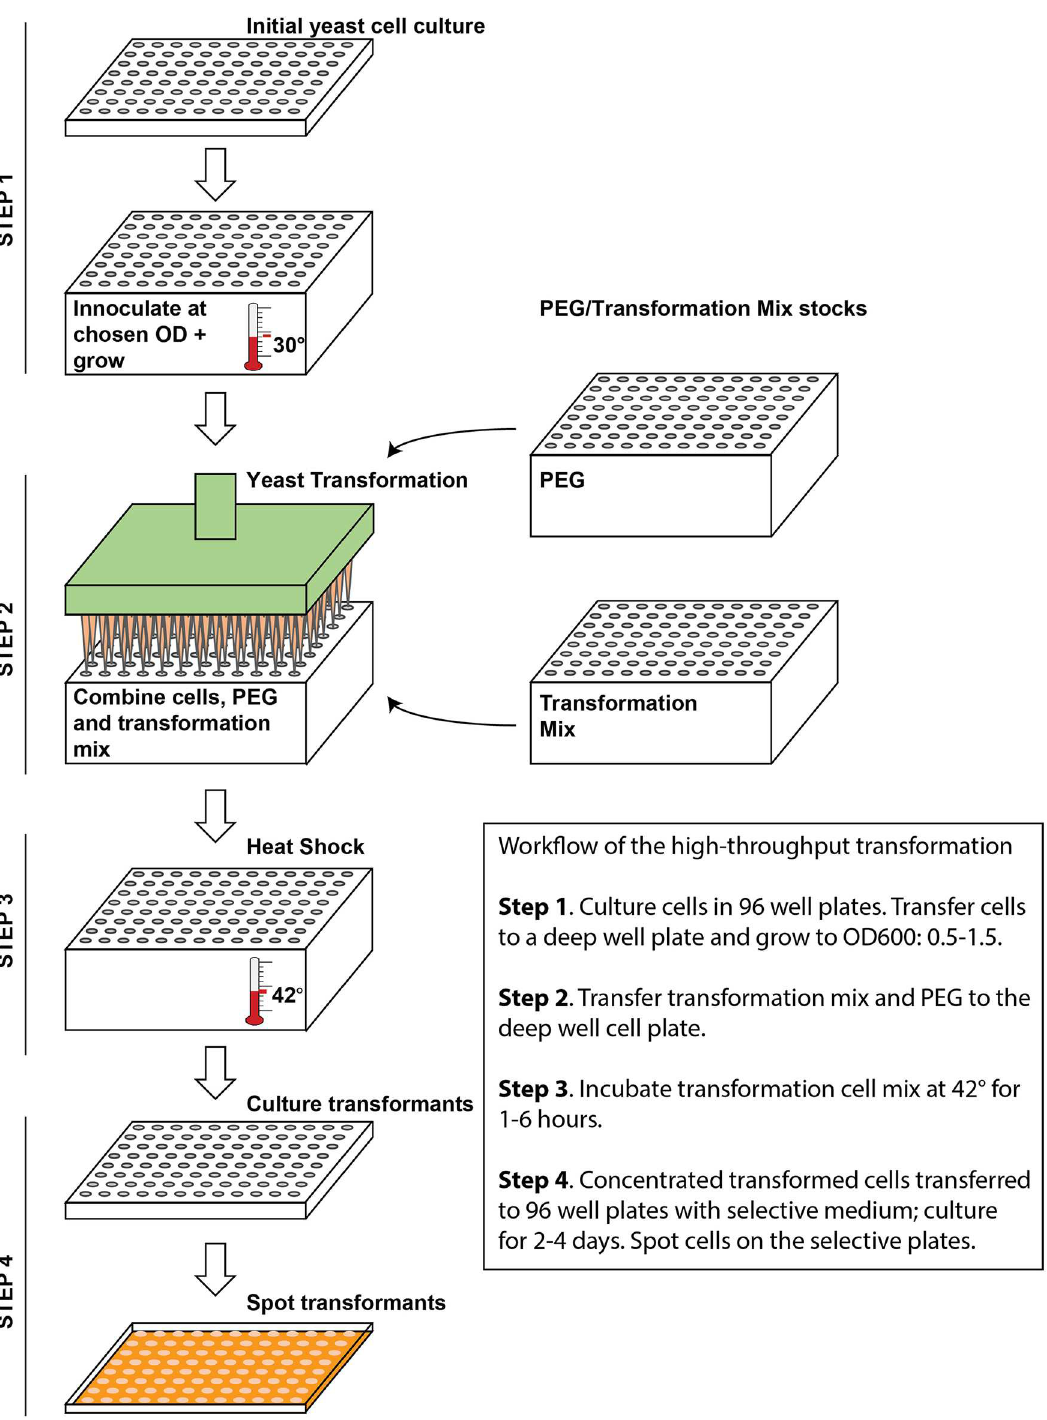
PLOS ONE | https://doi.org/10.1371/journal.pone.0174128 March 20,